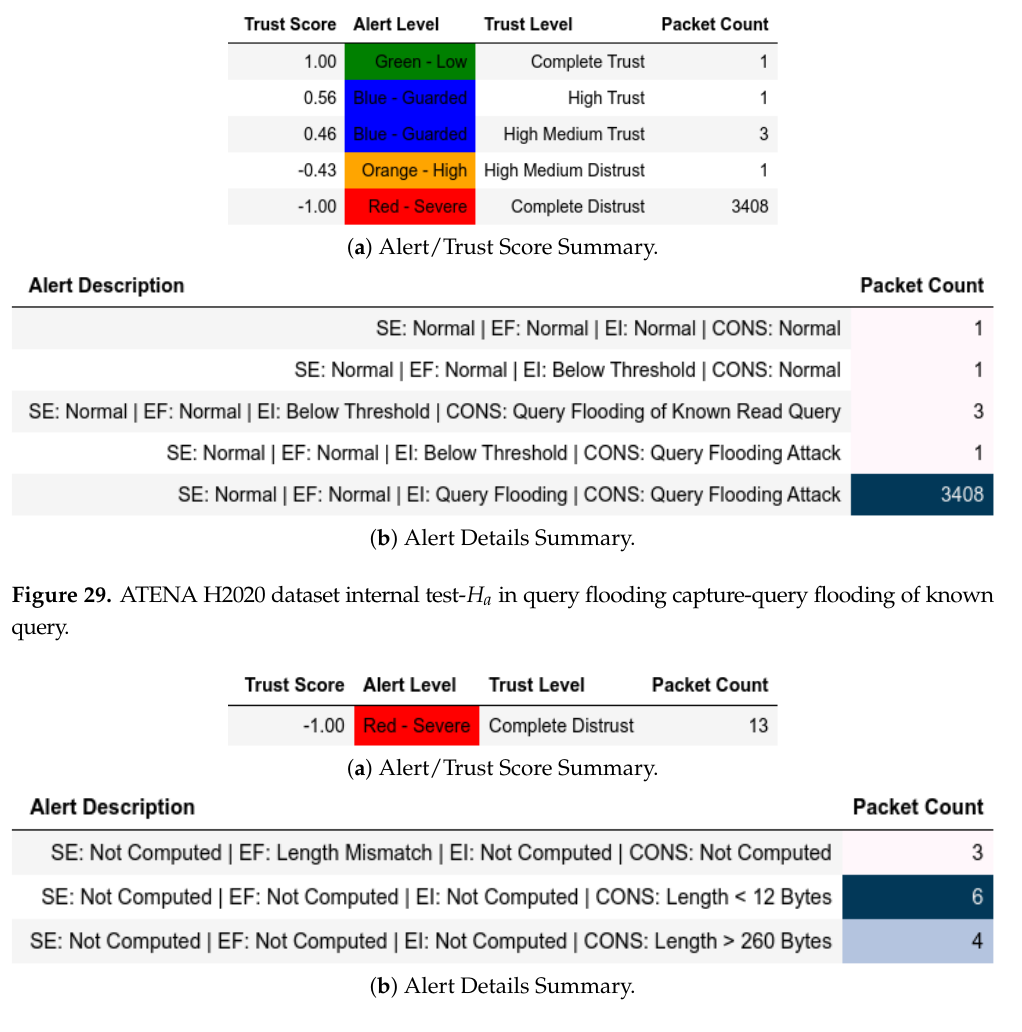
Figure 30. ATENA H2020 dataset internal test- H a in ping flood capture-maliciously crafted